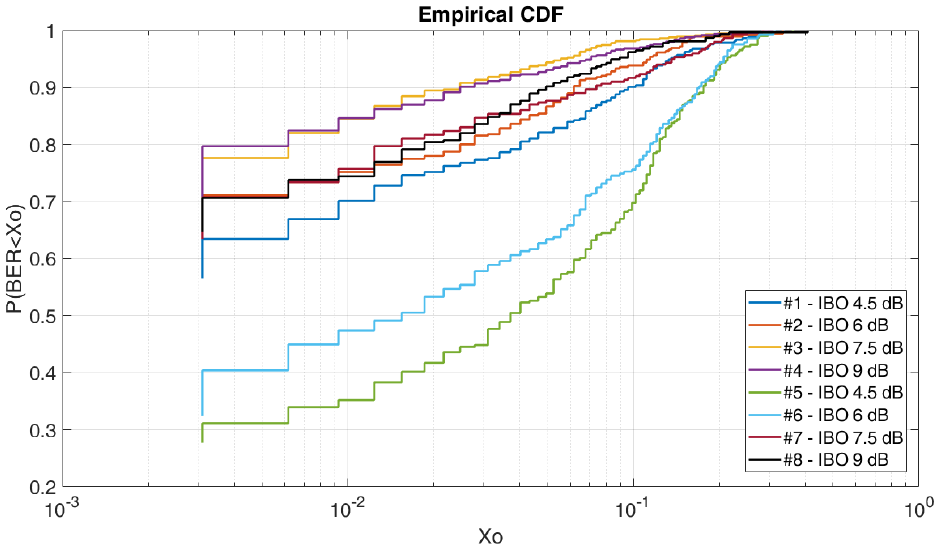
Figure 16. BER CDF vs. IBO.